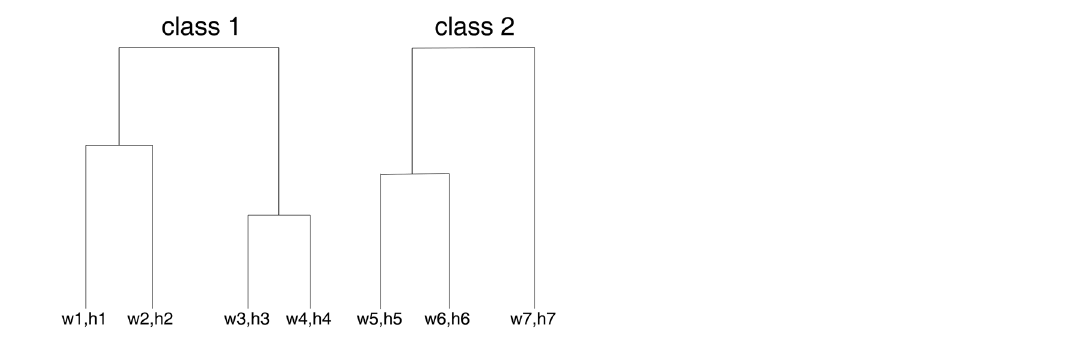
Figure 4. Partial renderings of hierarchical